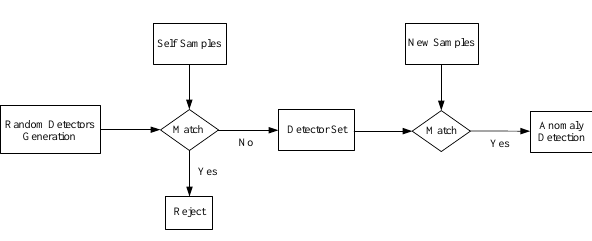
Fig. 1. Negative Selection Algorithm